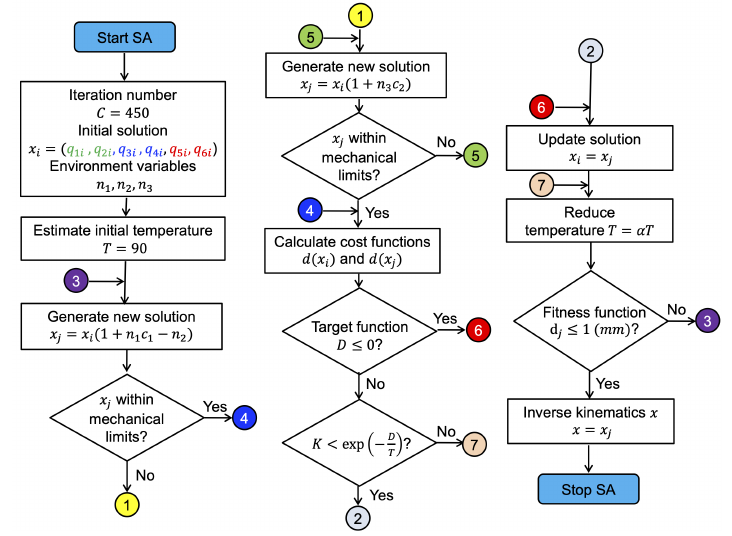
Figure 4. SA algorithm